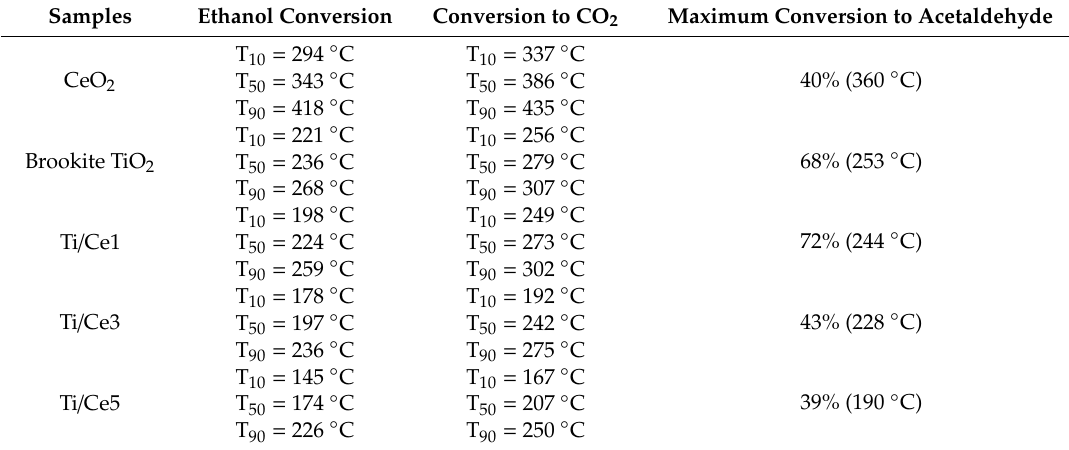
Table 6. Ethanol photothermo-catalytic oxidation over the investigated